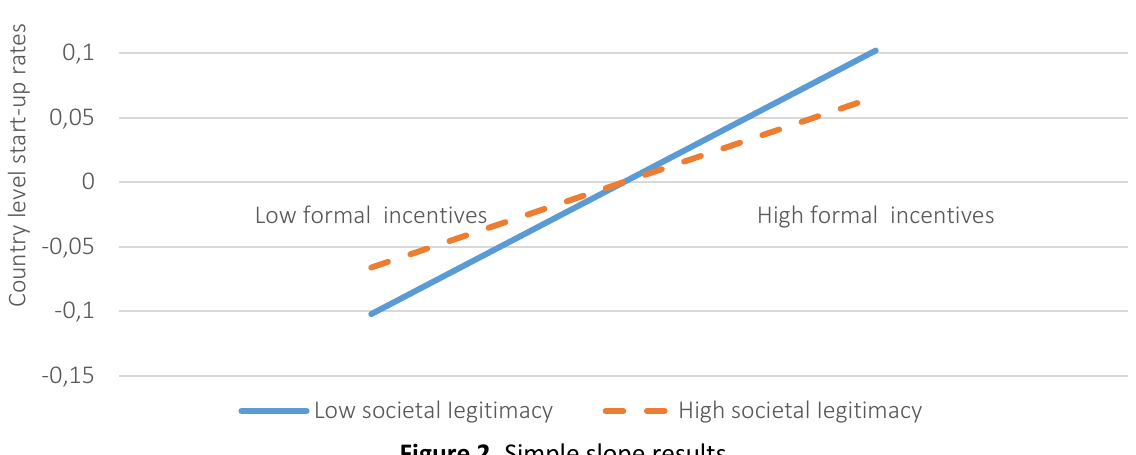
Figure 2. Simple slope